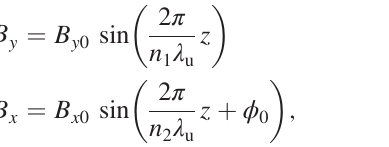
Figure 8 undulator and the APPLE-Knot undulator, respectively.